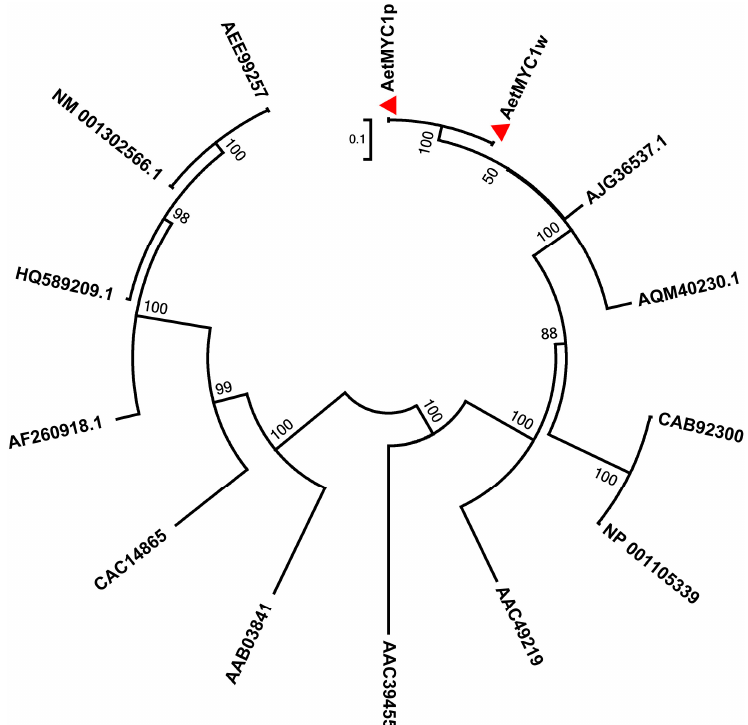
Figure 3. Phylogenetic relationships between AetMYC1 and bHLHs in other species. The accession